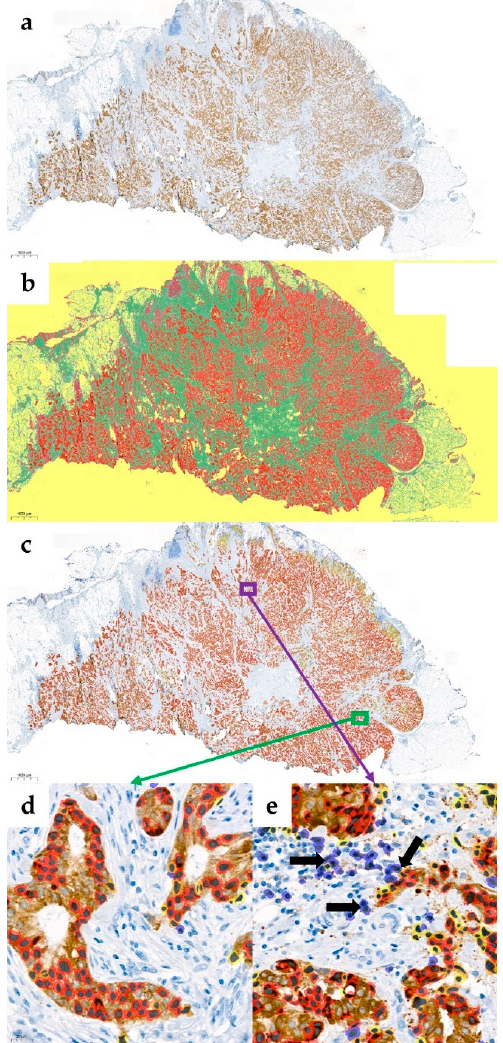
Figure 1. An example of automated quantification of staining for fibroblast growth factor receptor-2 (FGFR2) using H00002263-M01 antibody (Abnova, Taipei City, Taiwan) on digital scan (Pannoramic 250 Flash III scanner, CaseViewer / QuantCenter software, 3DHISTECH, Sysmex, Budapest, Hungary). The case was evaluated as strong positive for FGFR2 (FGFR2high) in both pathologic and automated scoring with H-score values of 274 (80 × 3 + 15 × 2 + 4 × 1 + 1 × 0) and 230 (59 × 3 + 18 × 2 + 17 × 1 + 6 × 0). ( a ) Immunostaining for FGFR2 with hematoxylin counterstaining, 1 × magnification. ( b ) Areas / features correctly identified by the software: cancer cells (red), tumour stroma (green), and background / non-tumoral tissue (yellow), 1 × magnification. ( c ) Automated measurement of FGFR2 expression under 1 × magnification: red / strong—in most of the selected cancer cells, orange / moderate and yellow / weak—in small subsets of cancer cells, blue / none in several incorrectly selected non-tumoral cells. ( d ) High magnification (40 × ) of representative area (indicated by a green square and arrow on (c) with cancer cells correctly identified and evaluated by the software. ( e ) High magnification (40 × ) of representative area (indicated by a purple square and arrow on (c) with incorrectly identified cells: cancer cells overlooked by the software and false–positive tumour-associated immune cells classified as FGFR2-negative cancer cells (black arrows). Scale bars indicating 1000 µ m ( a – c ) and 10 µ m ( d , e ) are included in the left bottom corner of each image. Images were taken by snapshot tool integrated in CaseViewer